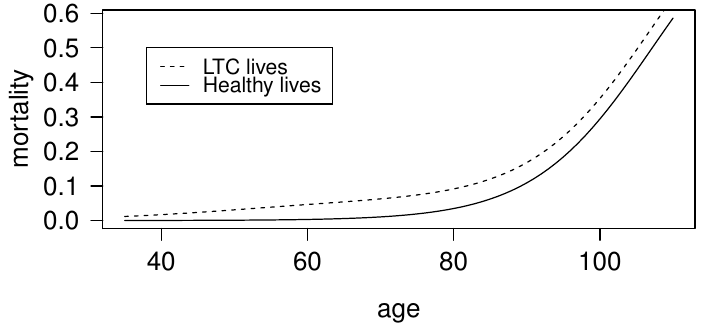
Figure 4. Functions q aa x and q i x ( i.e. , mortality of healthy lives and LTC lives, as functions of the attained age x ):